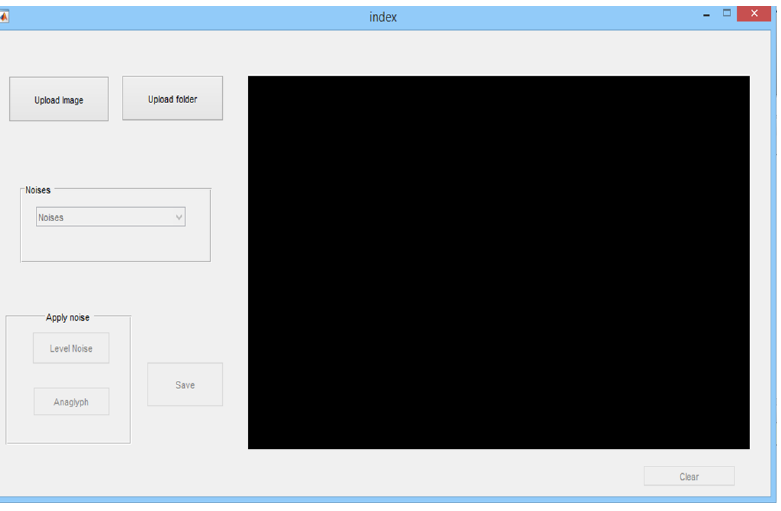
Figure 15. 3D22 MX Toolbox main